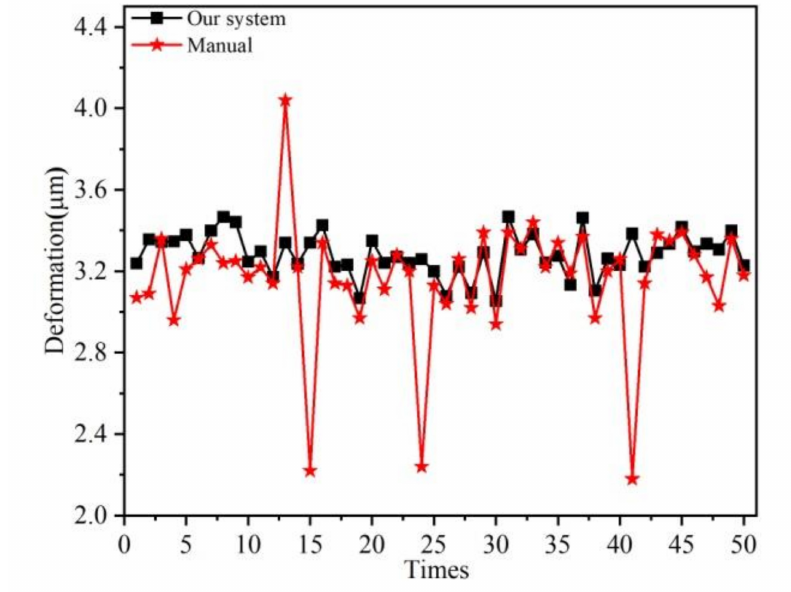
Figure 13. Measurement results of 50 wafers by using our system and the manual